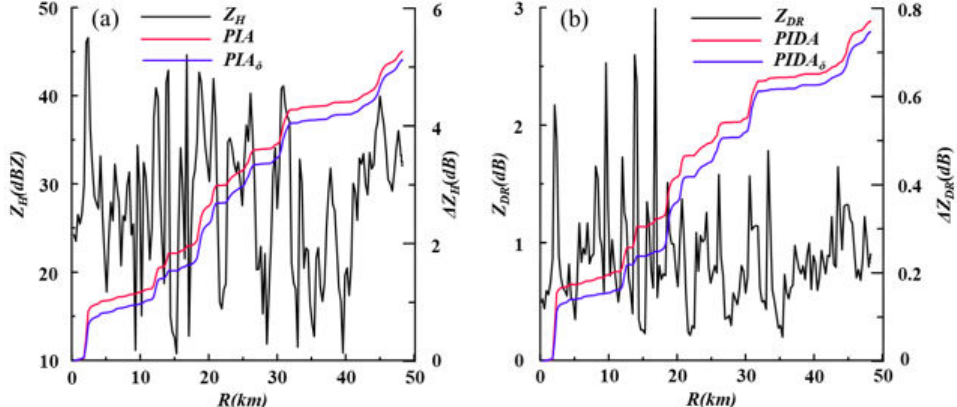
Figure 4. Comparison of the actual attenuation and attenuation correction for ( a ) Z H and ( b ) Z DR . The black line shows Z H or Z DR , the red solid line shows the actual PIA for reflectivity and path integrated differential attenuation (PIDA) for differential reflectivity, and the blue line shows the attenuation correction ( PIA δ and PIDA δ ); the differences between the red and blue curves are the errors in the attenuation correction caused by δ